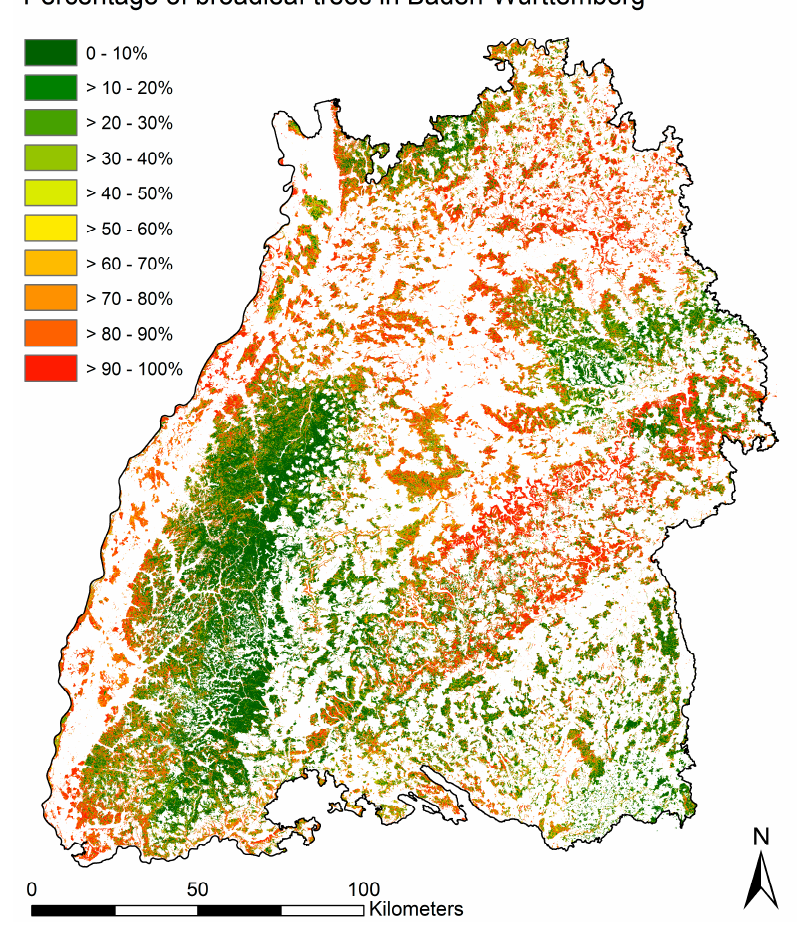
Figure A1. Map of BL% Figure B1. Map of BL% predictions.